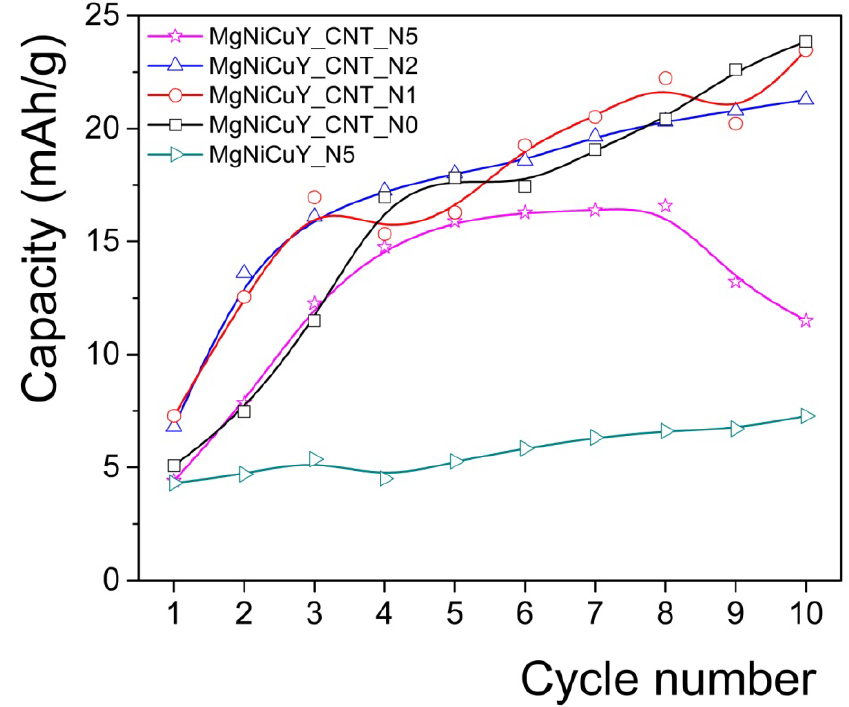
Figure 10. Electrochemical hydriding of MgNiCuY HPT disks.